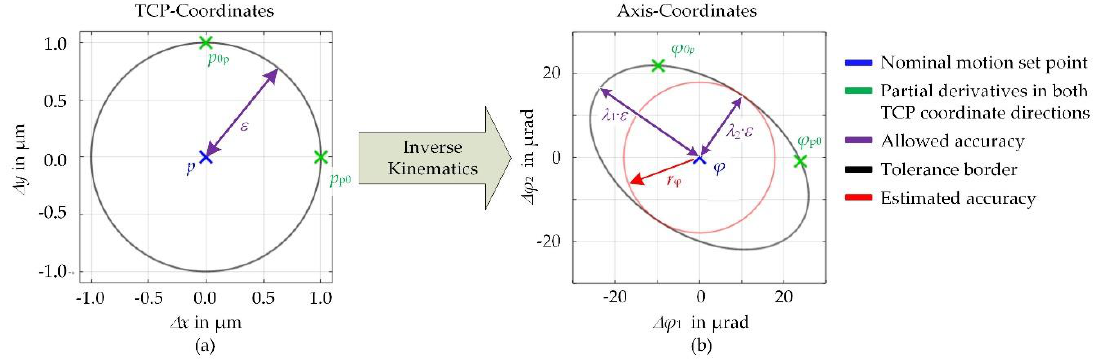
Figure 9. Distortion due to nonlinearity. ( a ) Tolerance circle in tool center point (TCP)-coordinate system, ( b ) distorted circle in axis coordinates.